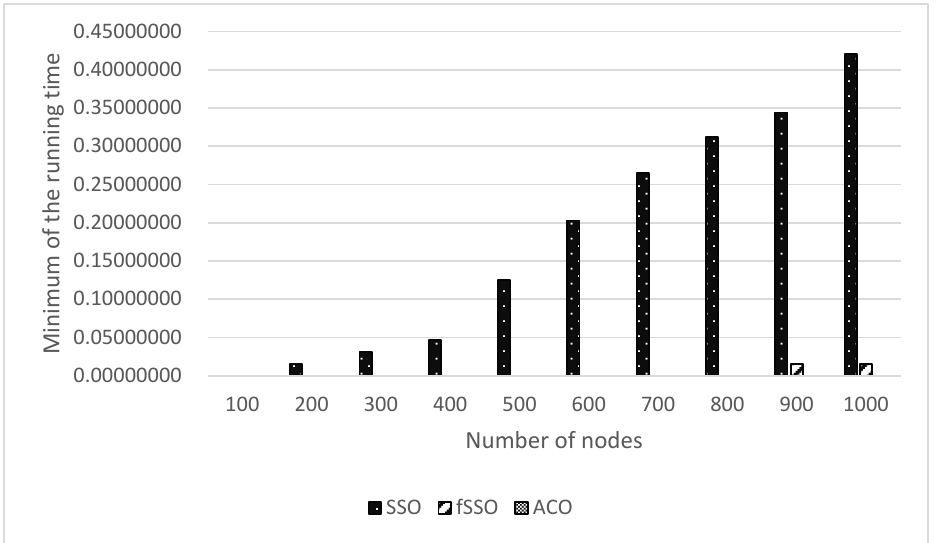
Figure 11. Minimum of the running time for ten benchmarks.